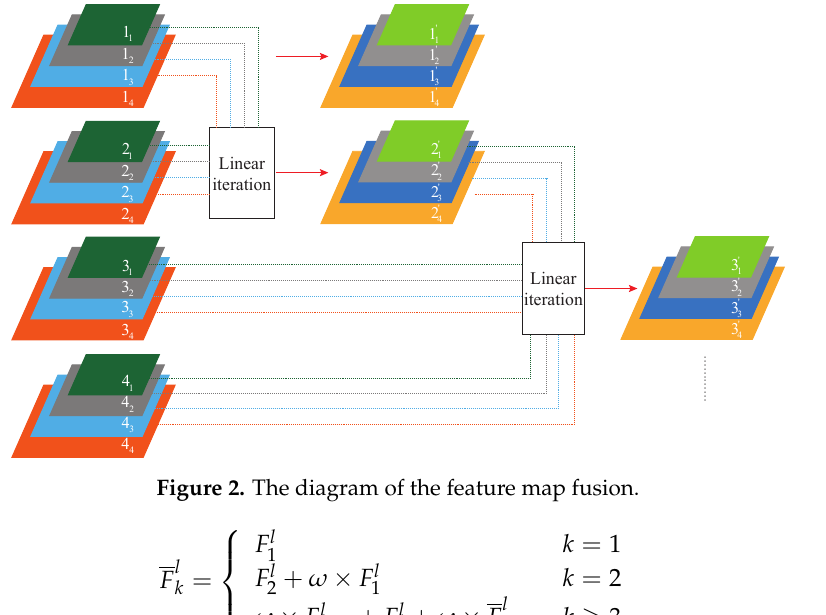
Figure 2. The diagram of the feature map